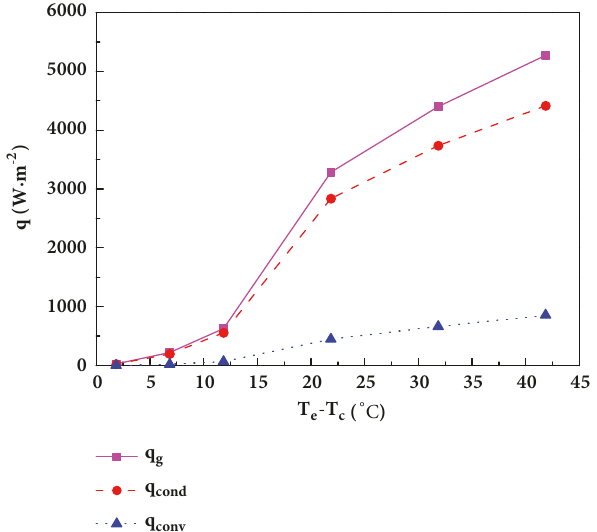
Figure 17: Effect of temperature difference on heat flux.